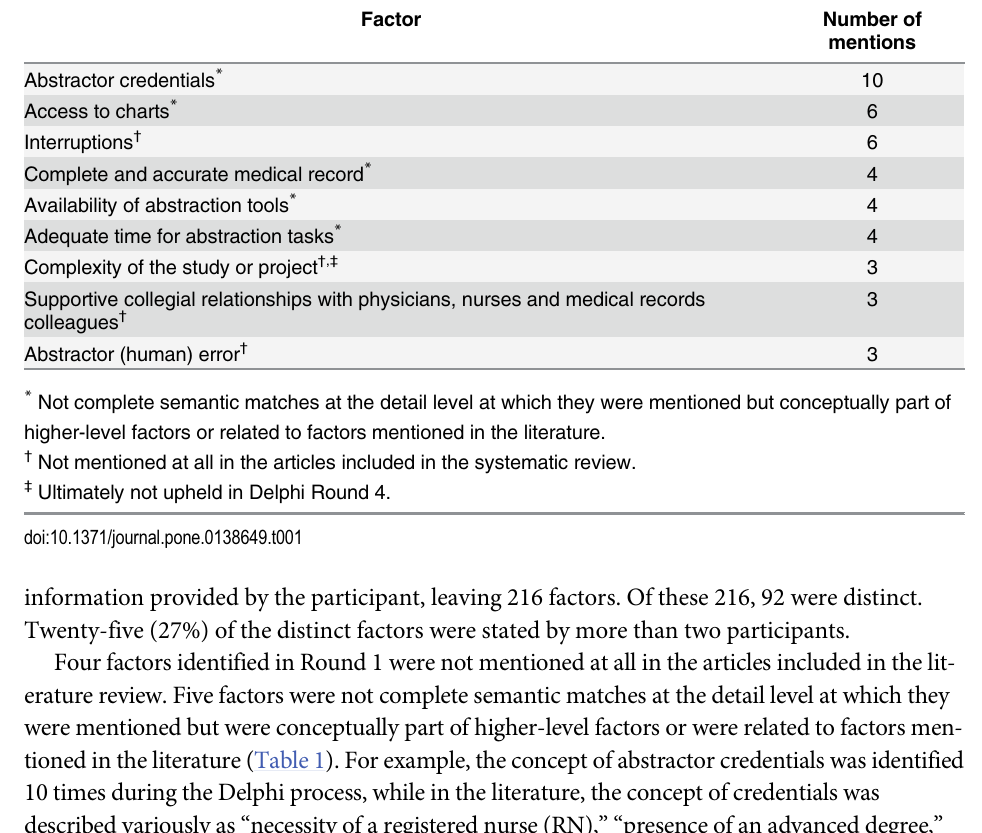
Table 1. Factors identified in Delphi Round 1 that were not in the literature.